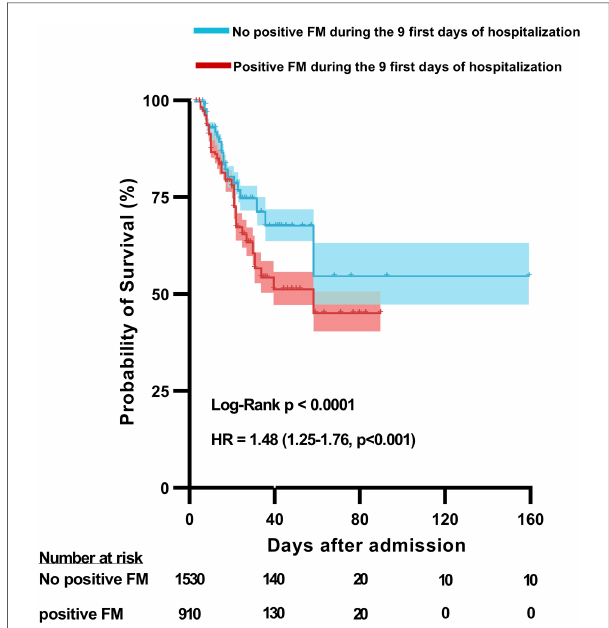
FIGURE 3 In-hospital mortality according to fi brin monomer positivity during the fi rst 9 days of hospitalization for COVID-19. Unadjusted Kaplan – Meier survival curve for mortality among all hospitalized COVID-19 patients according to whether patients displayed at least one positive fi brin monomer (FM) level (Blue line) or not (Red line) during hospitalization. The p -value refers to the log rank test. Estimates of the hazard ratio (HR) and 95% con fi dence intervals derived from a single Cox-model model assessing the association between at least one positive FM level during hospitalization and in-hospital